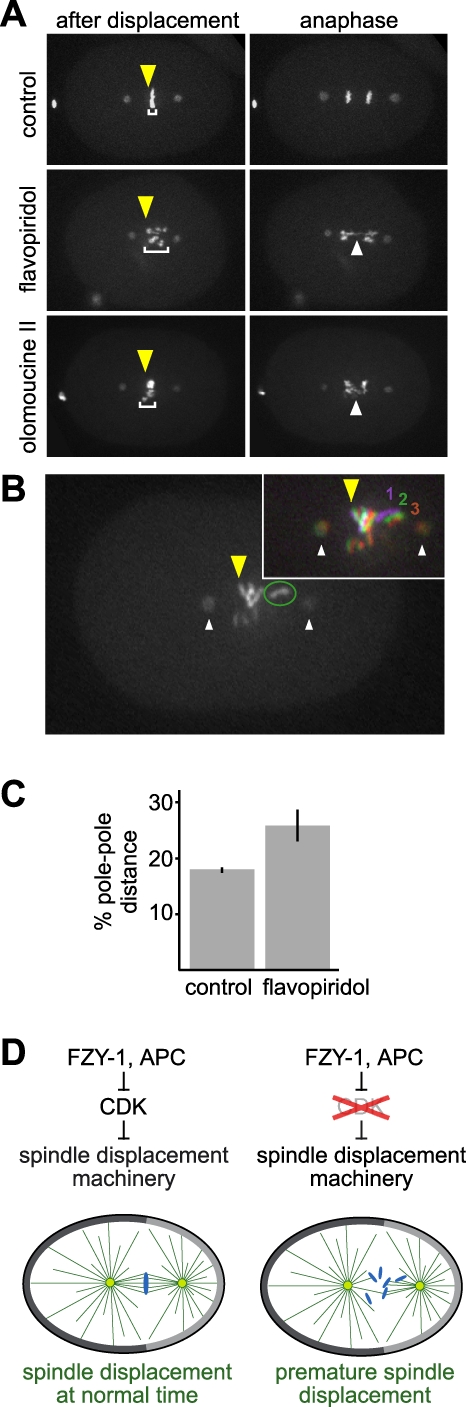
Flavopiridol Treatment Results in the Displacement of Incompletely Assembled Mitotic Spindles(A) Images of untreated, flavopiridol-treated, and olomoucine II-treated embryos after spindle displacement and in anaphase. The chromosomes have a wider distribution (brackets) along the anterior-posterior axis at the time of spindle displacement after flavopiridol or olomoucine II treatment. Yellow arrows indicate 50% embryo length. White arrows point to chromosome bridges in anaphase, likely to be a result of premature anaphase.(B) Movement of a chromosome toward a spindle pole after spindle displacement has begun in a flavopiridol-treated embryo. One chromosome (circled) is tracked in three color-coded timepoints (numbered 1, 2, 3) in the inset. Timepoints shown are 3 s apart. Yellow arrows indicate 50% embryo length, and white arrows indicate centrosomes.(C) Measurements of the degree of chromosome congression at the time of spindle displacement. After treating with flavopiridol after NEBD, chromosomes were not aligned on the metaphase plate as tightly as in WT. For statistical values and n-values, see Methods.(D) Model for the role of CDK regulation of spindle displacement: We speculate that a component of the spindle displacement machinery may be a direct or indirect target of CDK activity and that this produces the temporary delay in spindle displacement. CDK regulation of spindle displacement timing permits spindle assembly to complete before movement begins. Left, normal temporal regulation results in spindle displacement after congression completes; right, premature spindle displacement resulting from experimentally inactivating CDK early results in spindle displacement before congression completes. Colors are as in Figure 1A.